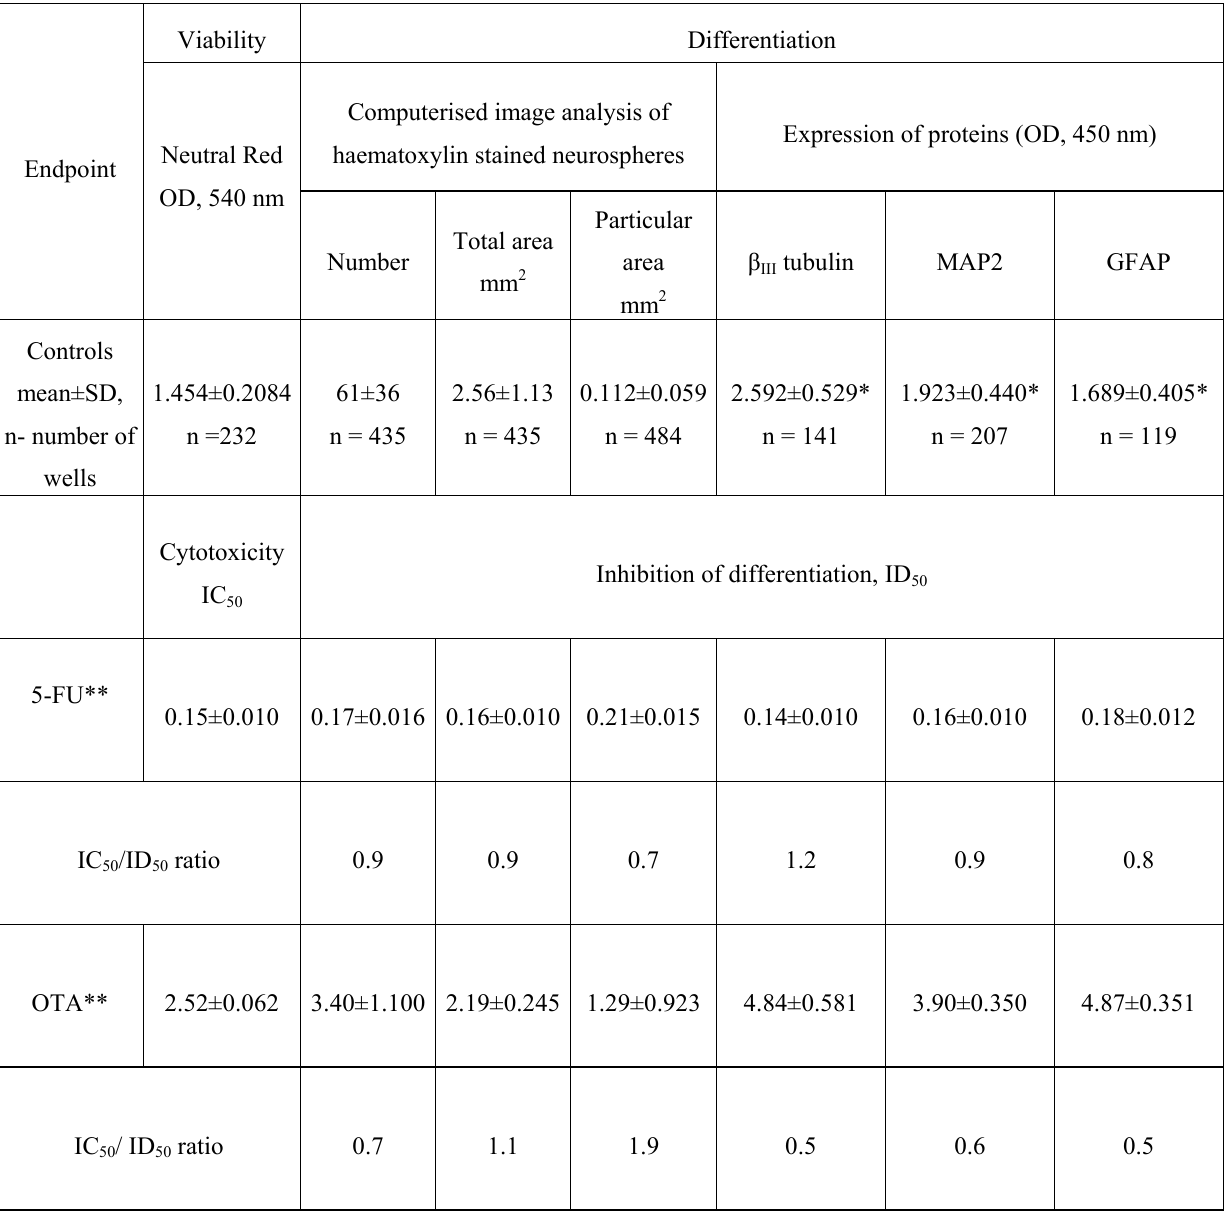
Table 1. Effects of 5-fluorouracil (5-FU) and ochratoxin A (OTA) on viability (NRU test) and differentiation (based on six